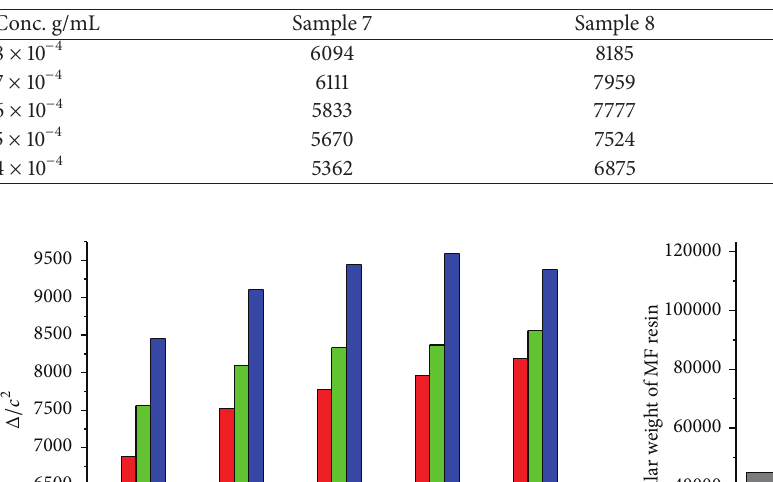
Table 3: Dependence of the concentration of sample (7–10) on Δ / 𝑐 2 .